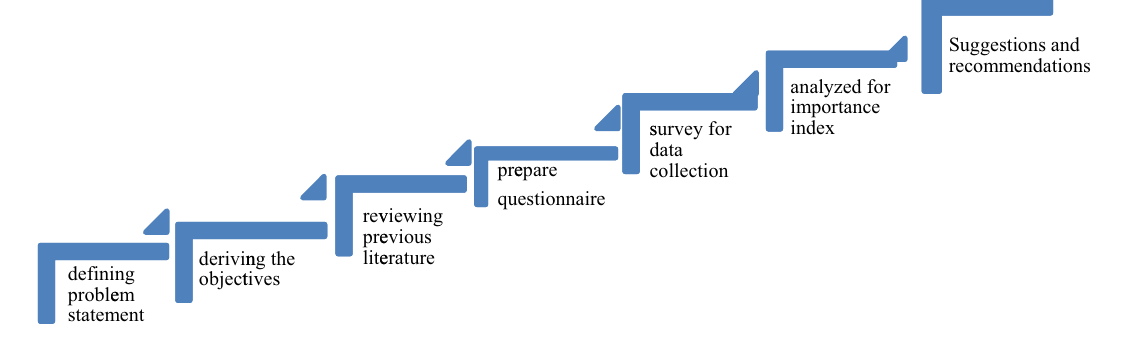
Figure 1: Research